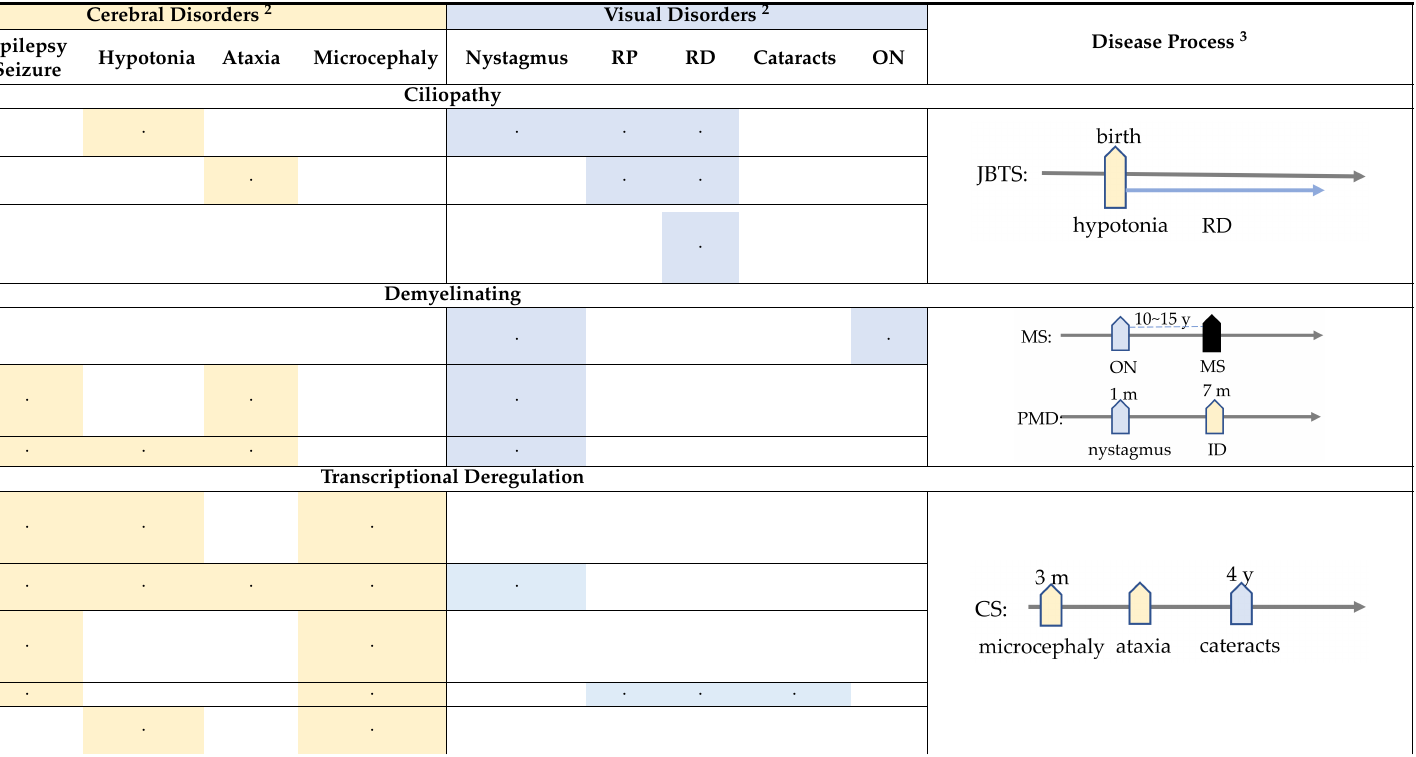
Table 4. Brain-Eye Parallelism in Cerebral Visual